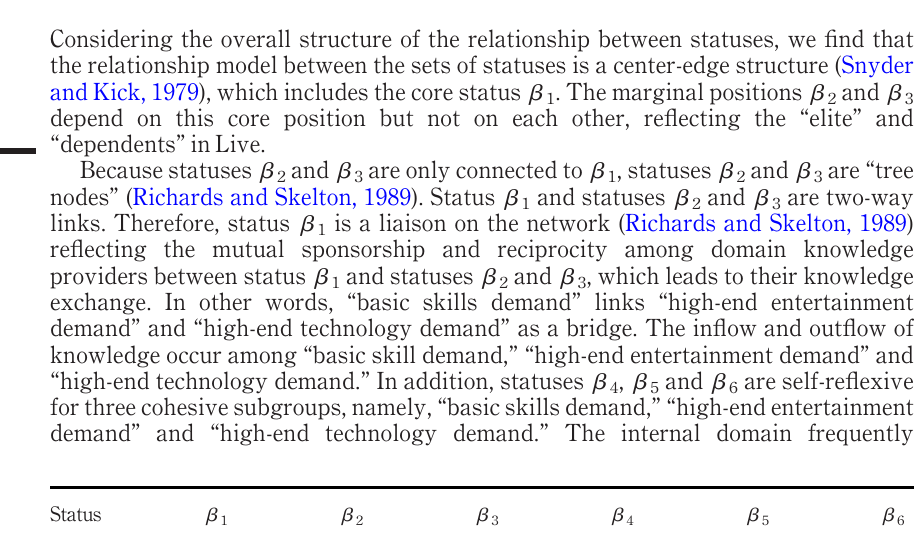
Table 3. Density table of cross-domain knowledge exchange relationships